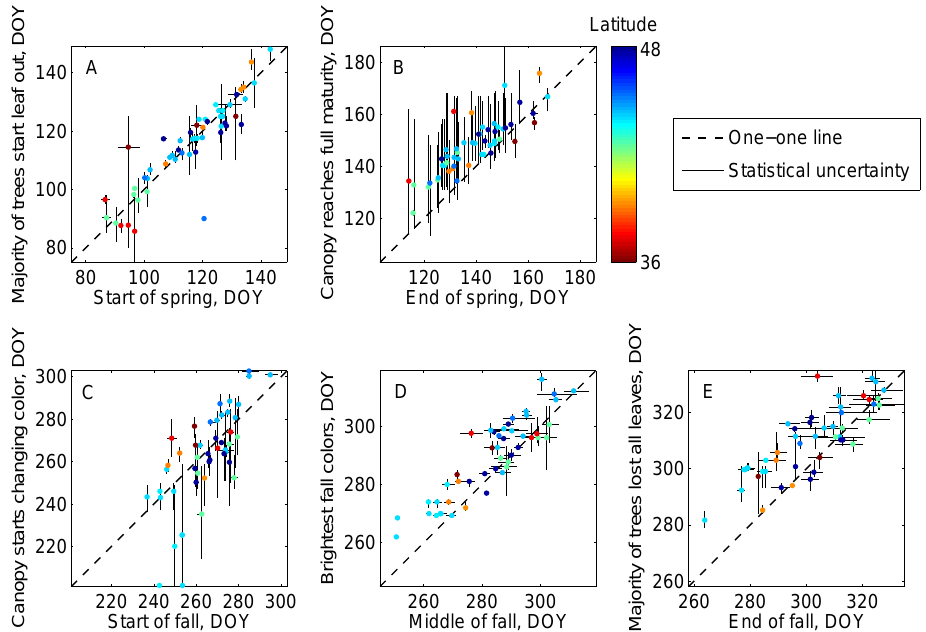
Figure 4. Scatterplots of the comparison between visually assessed dates ( y axis) and dates identified from near-surface GCC ( x axis) using the generalized sigmoid method. Table 2. Statistical uncertainty in estimated phenology dates. Statistical uncertainty in sigmoid-based methods is calculated as the average width of inner 95% confidence intervals for each phenology date. SOS, MOS, and EOS are start, middle, and end of spring. SOF, MOF, and EOF are start, middle and end of fall. Statistical uncertainty in visual assessment is calculated as the average length of time between earliest and latest assessments, after removing the minimum and maximum estimates from the raw data. All units are in